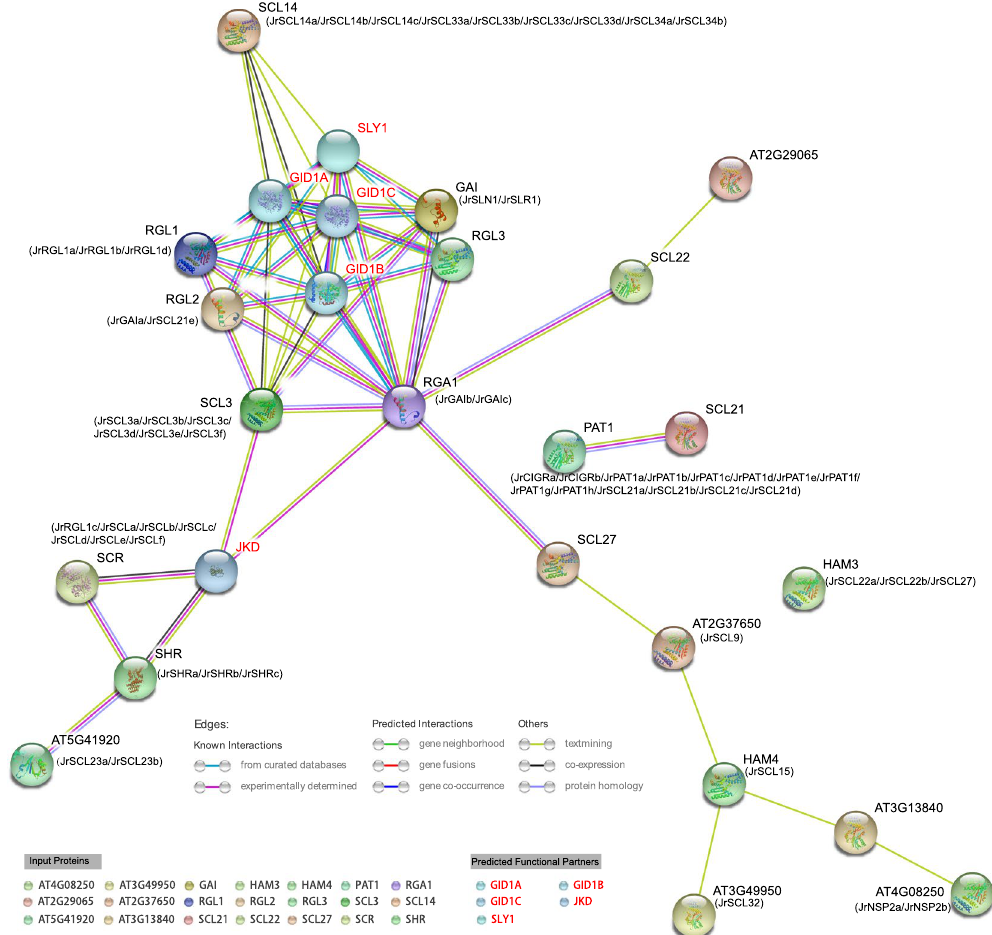
Figure 8. Predicted protein-protein interaction network of Jr GRAS proteins. The network nodes represent proteins, the 3D structure of the proteins is shown inside the nodes and the colors of the line indicate different data